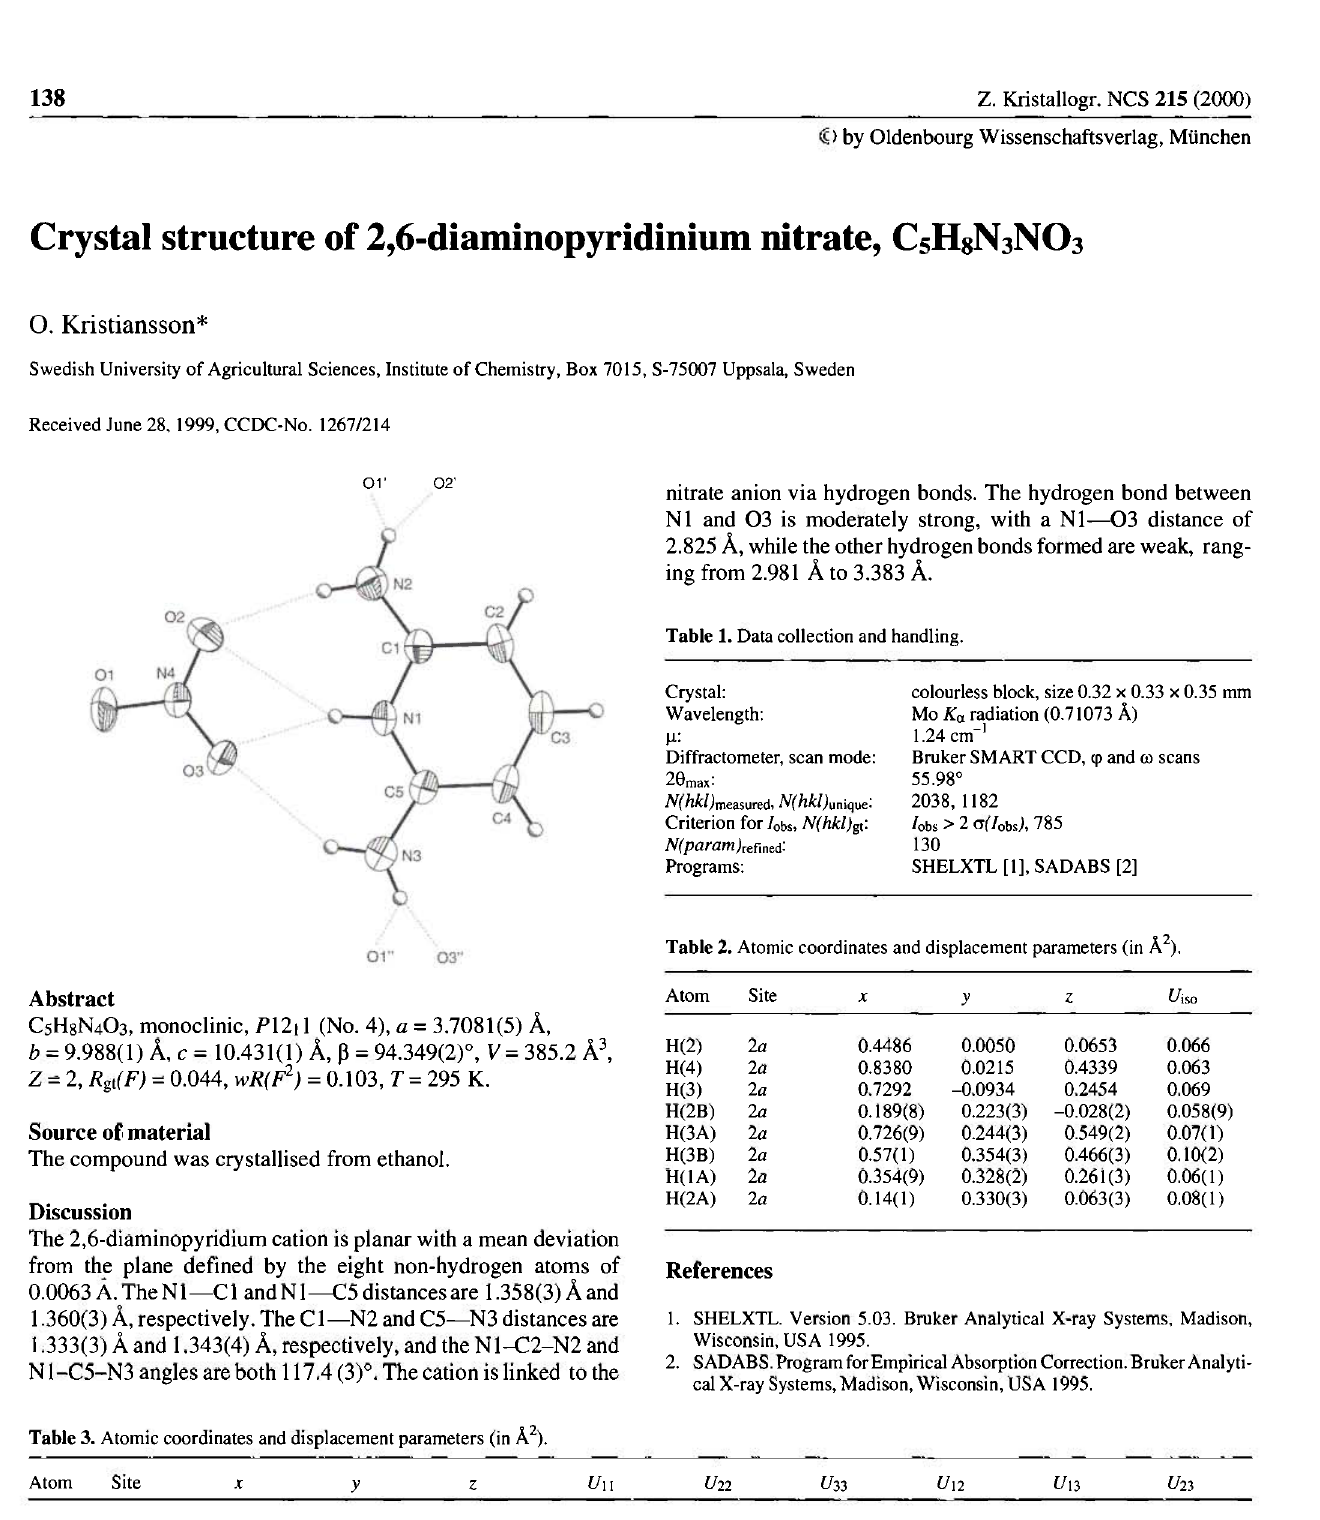
Table 3. Atomic coordinates and displacement parameters (in Ä 2 ).